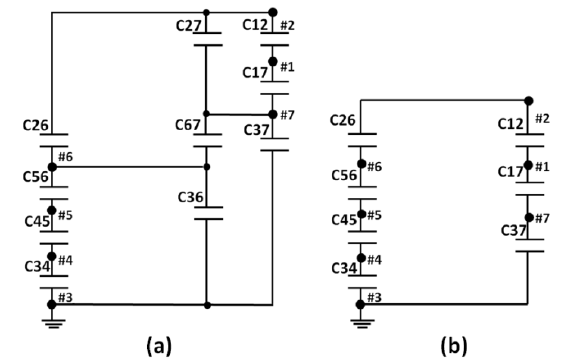
Figure 12. (a) simplified circuit A and (b) simplified circuit